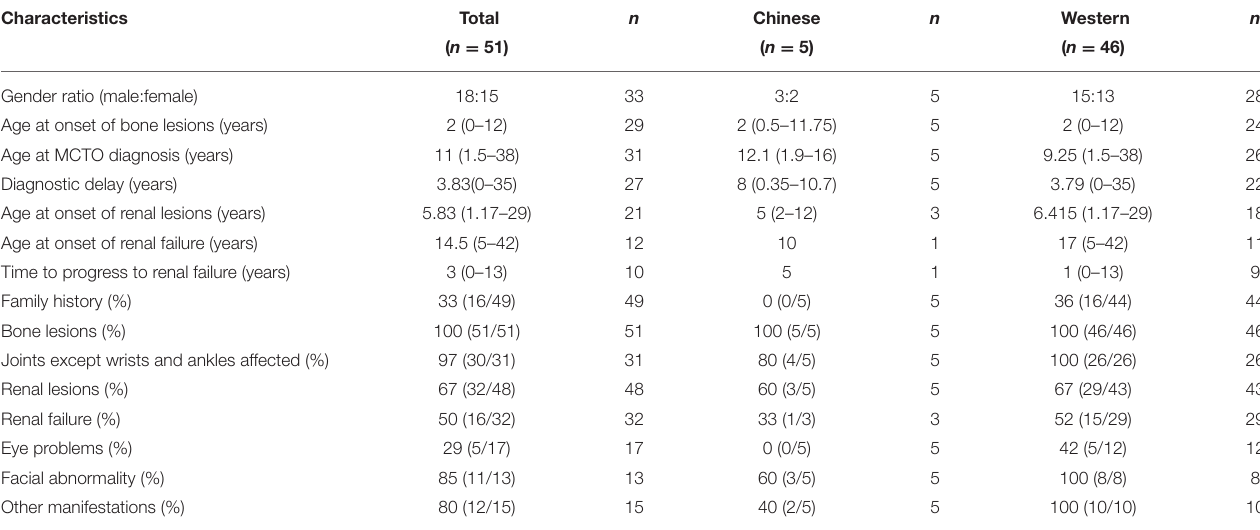
TABLE 2 | Comparison of the major clinical features between Chinese patients with those in other cohorts. Characteristics Total n Chinese n Western